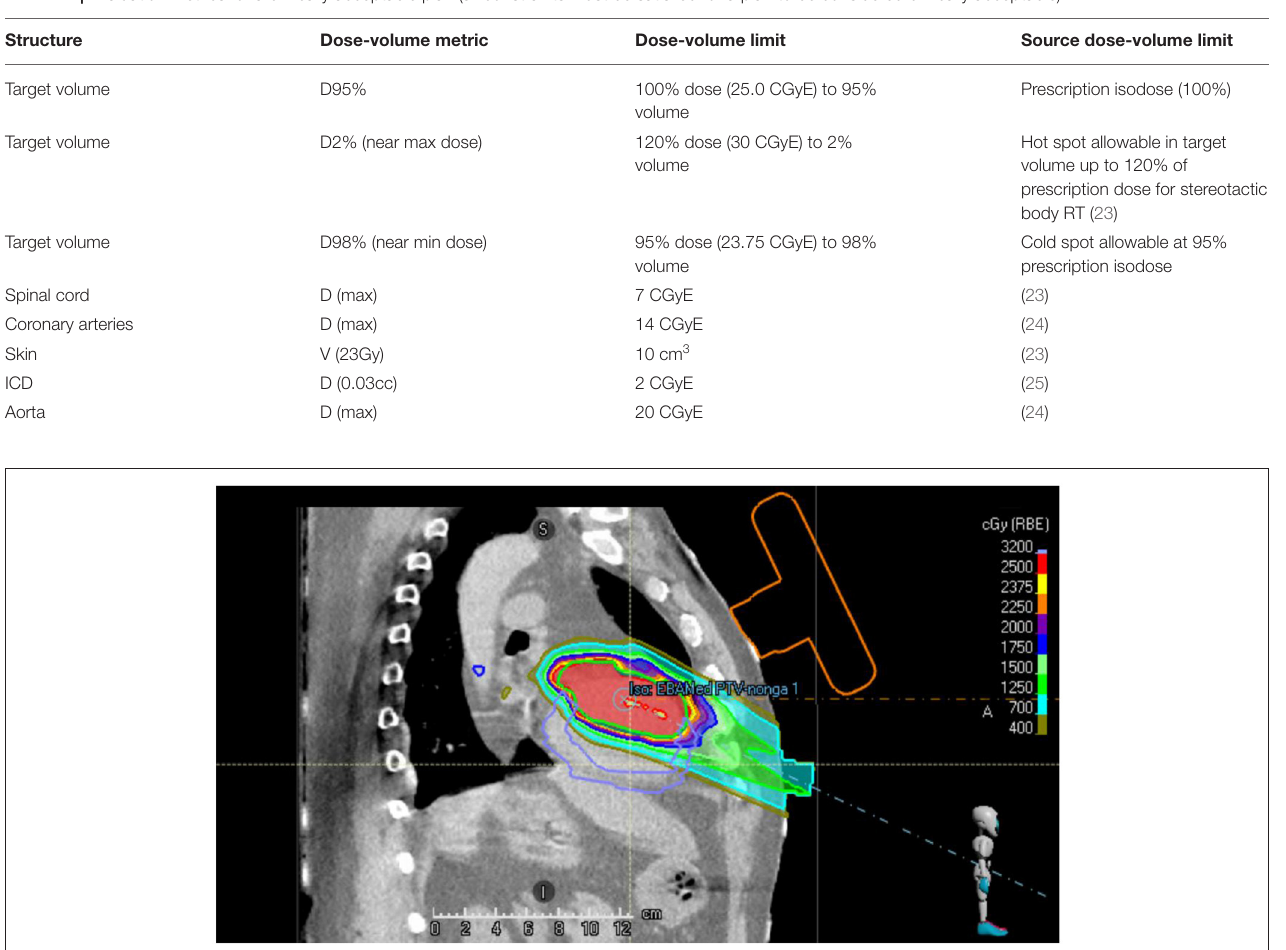
FIGURE 2 | Sagittal slice of the single beam proton plan generated for the VT patient. The location of the virtual US probe with localization marker on the chest of the patient is shown in